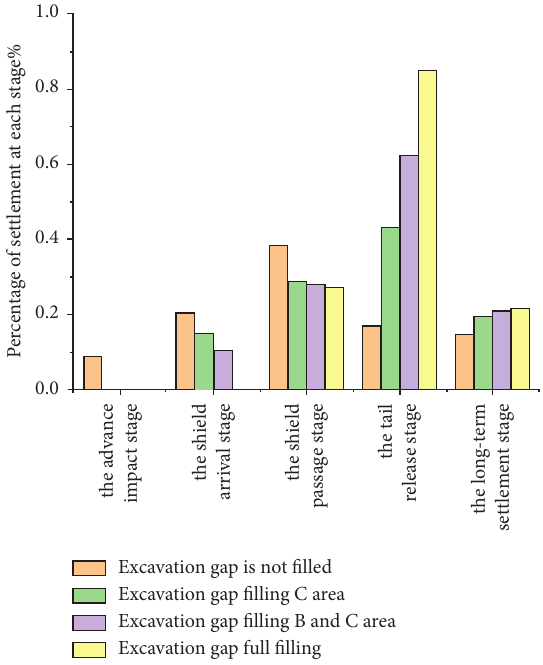
Figure 30: Proportion of settlement at each stage.